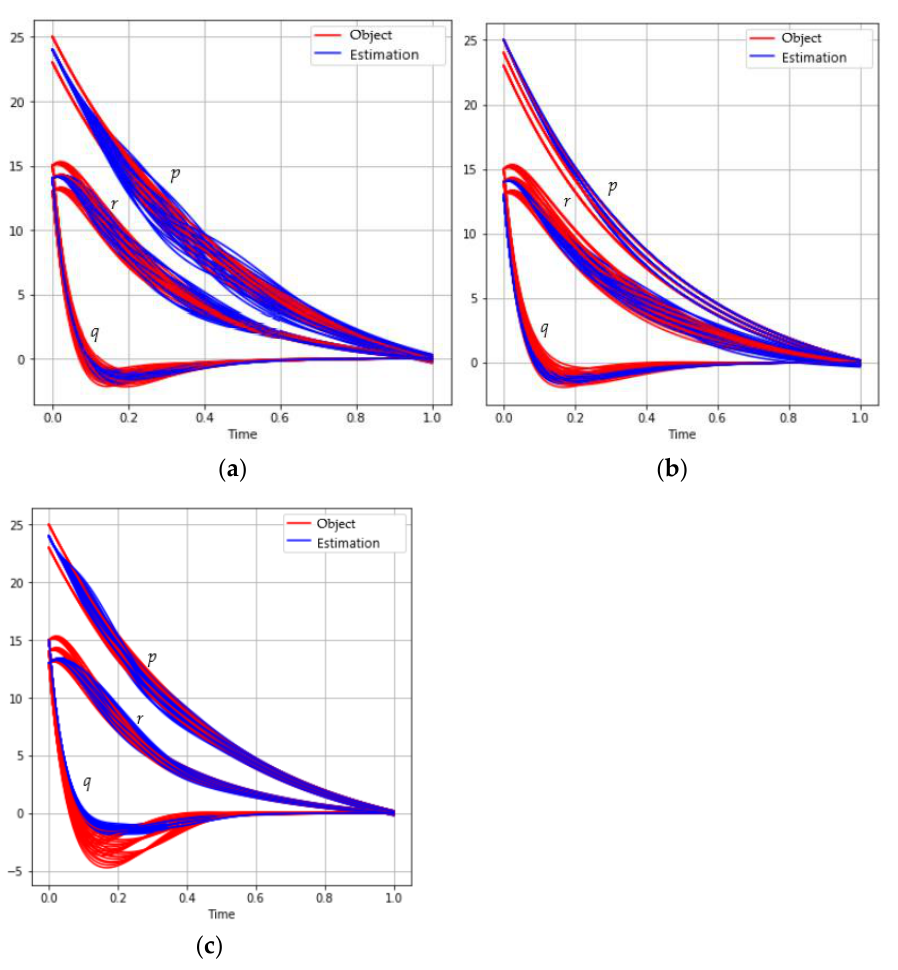
Figure 3. The behavior of the satellite coordinates , , p q r (red) and estimations (blue) for different mini-batch sizes: ( a )